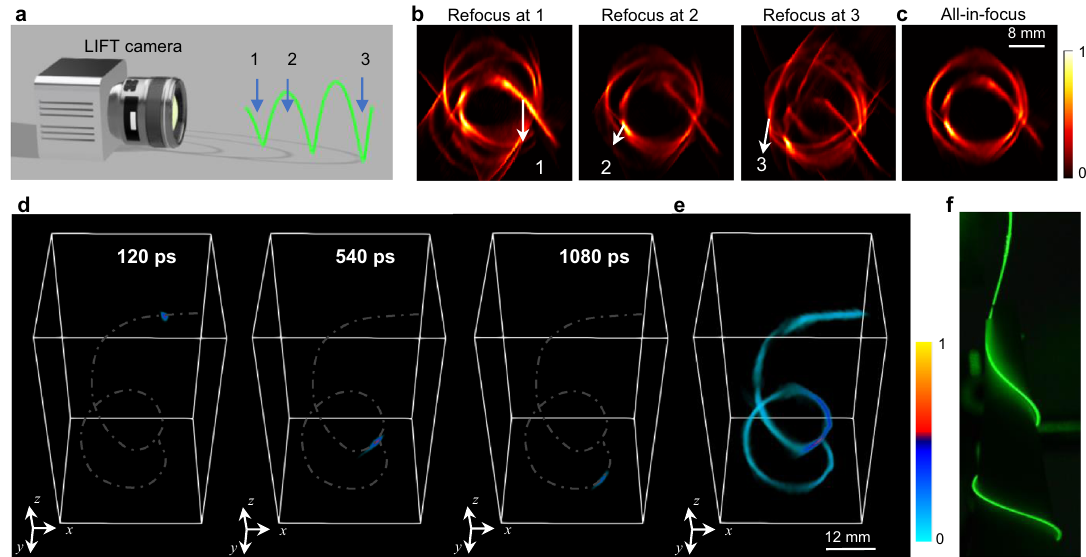
Fig. 2 Transient light fi eld imaging by a LIFT camera. a Experimental setup. b Post-capture refocusing at different depths. The images are time-integrated so that all parts of the helical fi ber can be rendered, which are otherwise separated at different time instances. c All-in-focus time-integrated imaging results. d 4D (3D space and time) characterization of a picosecond laser pulse propagating inside a light-diffusing fi ber. The helical fi ber structure is crafted and overlaid in each 3D frame for visual guidance. e Time-integrated 3D image of the helical fi ber. f Photograph of the helical fi